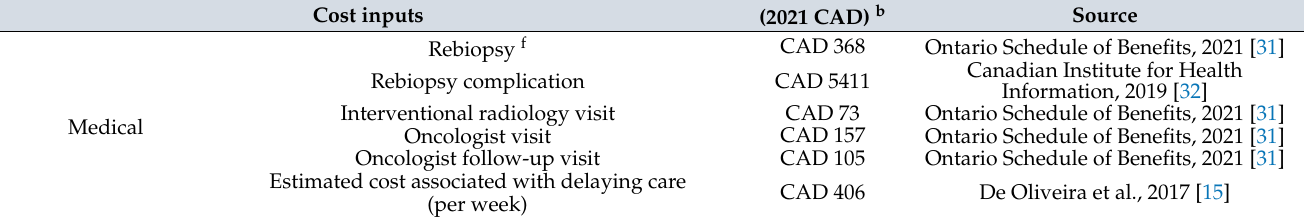
Table 1. Summary of model